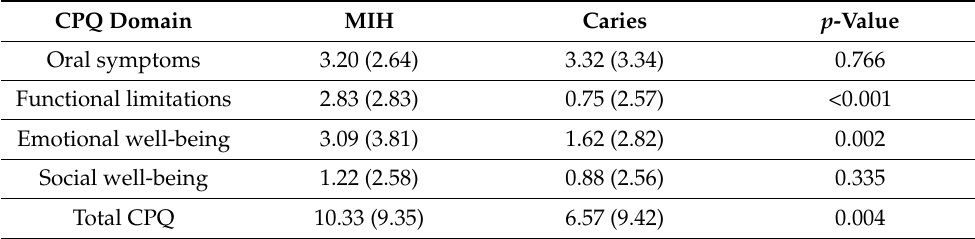
Table 5. Difference in Means between MIH and Caries group in CPQ